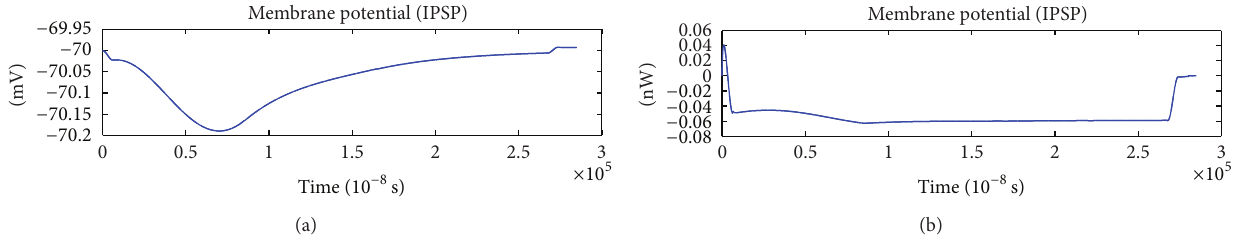
Figure 4: IPSP and its corresponding energy function. 𝑟 0𝑚 = 0.0001 Ω , 𝑟 1𝑚 = 0.1 Ω , 𝑟 2𝑚 = 1000 Ω , 𝑟 3𝑚 = 0.1 Ω , 𝑟 𝑚 = 1000 Ω , 𝐶 𝑚 = 1 𝜇 F, = 50 𝜇 H, and 𝑖 = −0.7𝜇 𝐿 𝑚 0𝑚